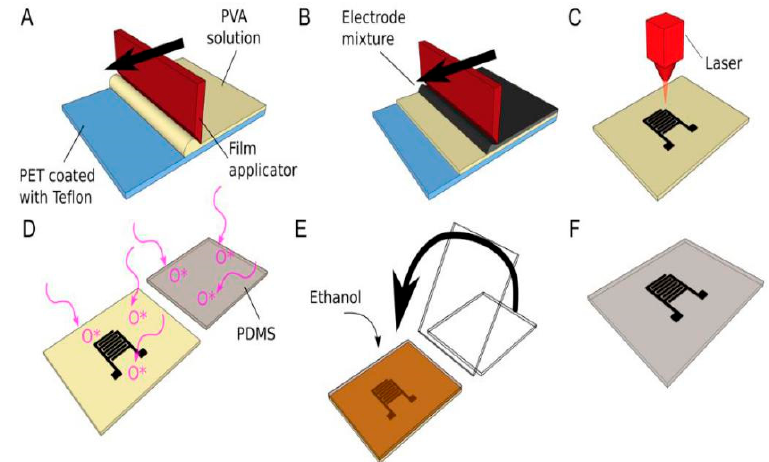
Figure 5. ( a – f ) Schematic representation of the fabrication process of the carbon-PDMS composites. Poly (vinyl alcohol) (PVA) aqueous solution followed by carbon/PDMS composites were cast on the